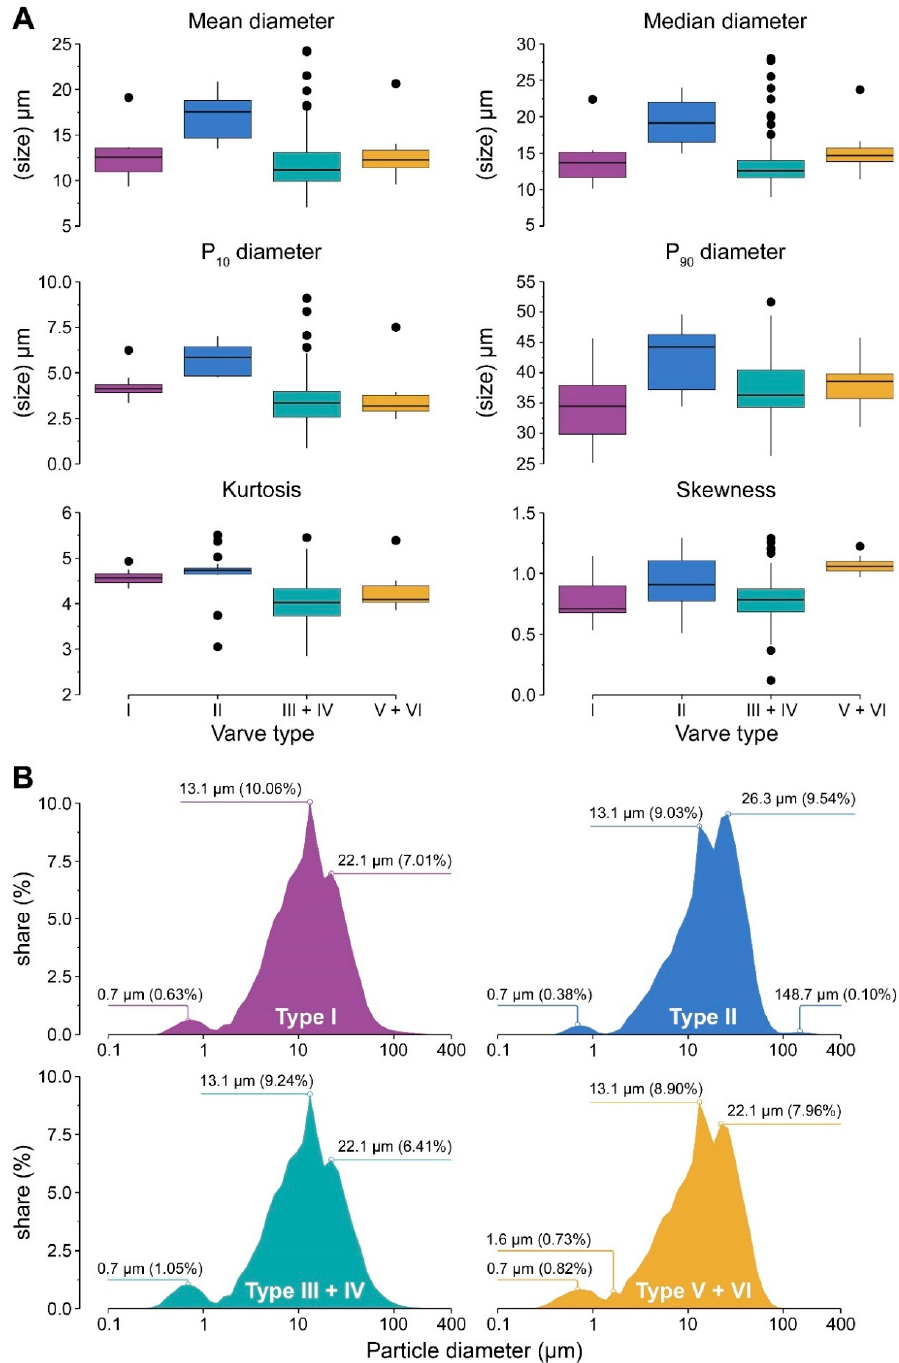
Figure 5. ( a ) Boxplots of main grain-size indices and parameters aggregated by varve type. ( b ) Average grain-size distribution aggregated by varve type (labels indicate positions of modes, respective size, and relative share). Boxplots features as in Figure 4.